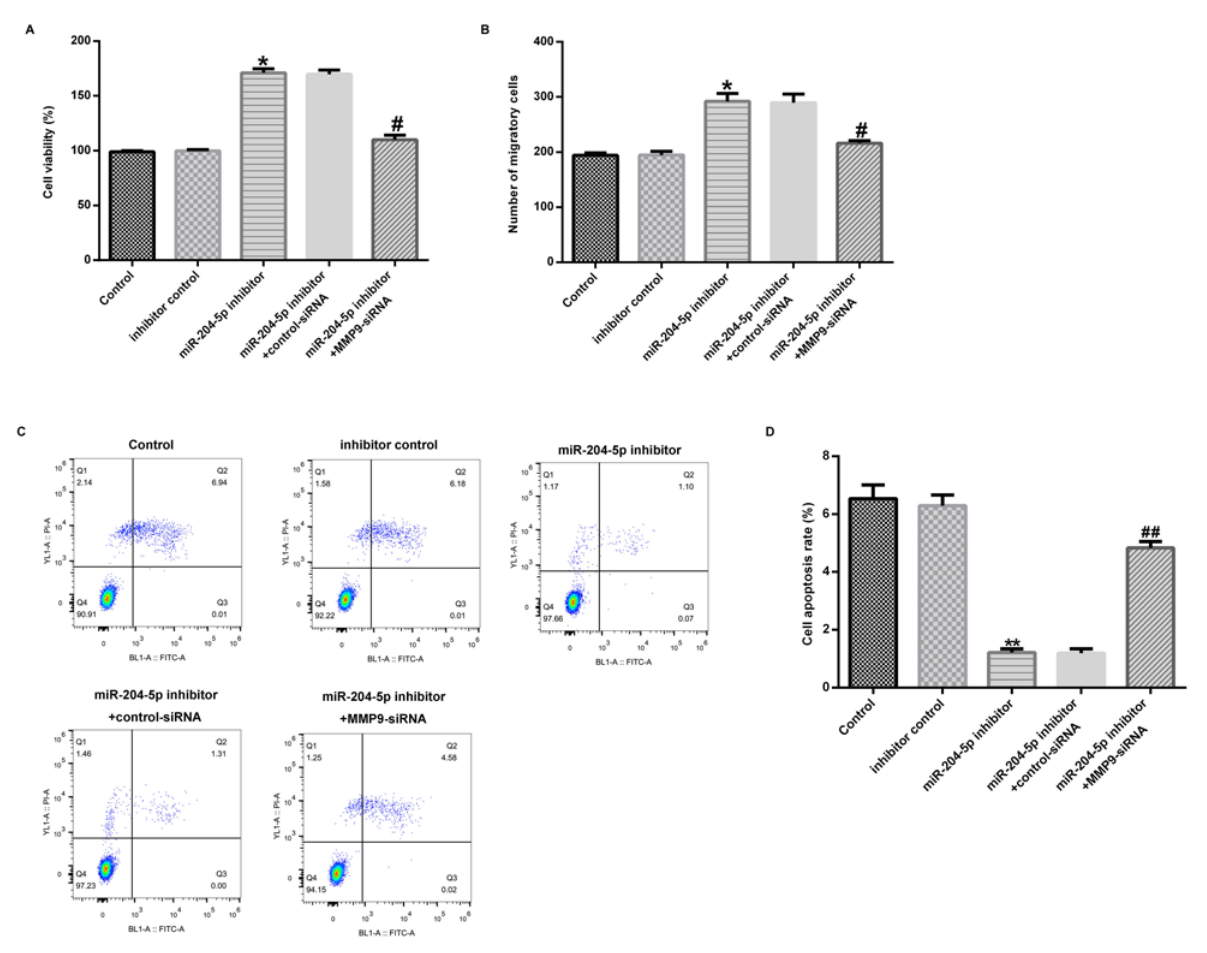
Figure 4: Downexpression of MMP-9 abrogated the promotion of miR-204-5p inhibitor on hVSMC growth and migration. hVSMCs were respectively transfected with inhibitor control, miR-204-5p inhibitor alone or accompanied with control-siRNA or MMP-9-siRNA for 48 h. (A) MTT assay was used to detect cell viability of hVSMCs. (B) The transwell assay was performed to check cell migration. (C and D) hVSMC apoptosis was detected by flow cytometric assay. Results were presented as mean ± SD. *, **p < 0.05, 0.01 vs. Control group; #, ## p < 0.05, 0.01 vs. miR-204-5p inhibitor